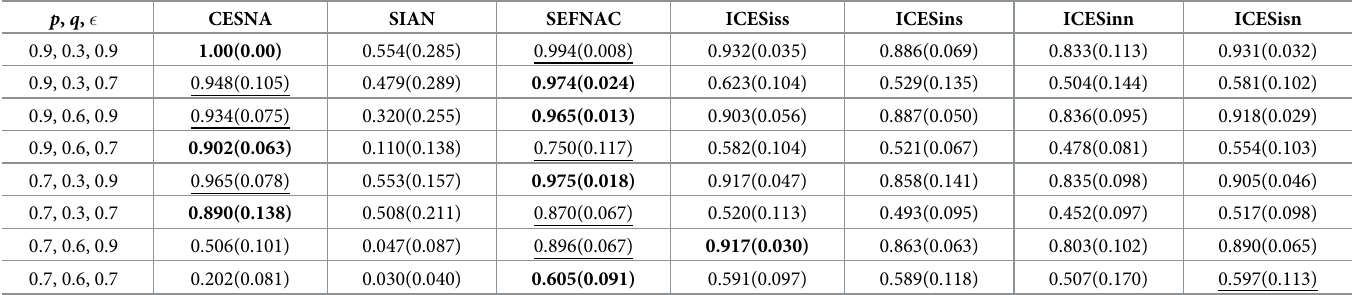
The best results are highlighted in bold-face and second ones are under-lined.